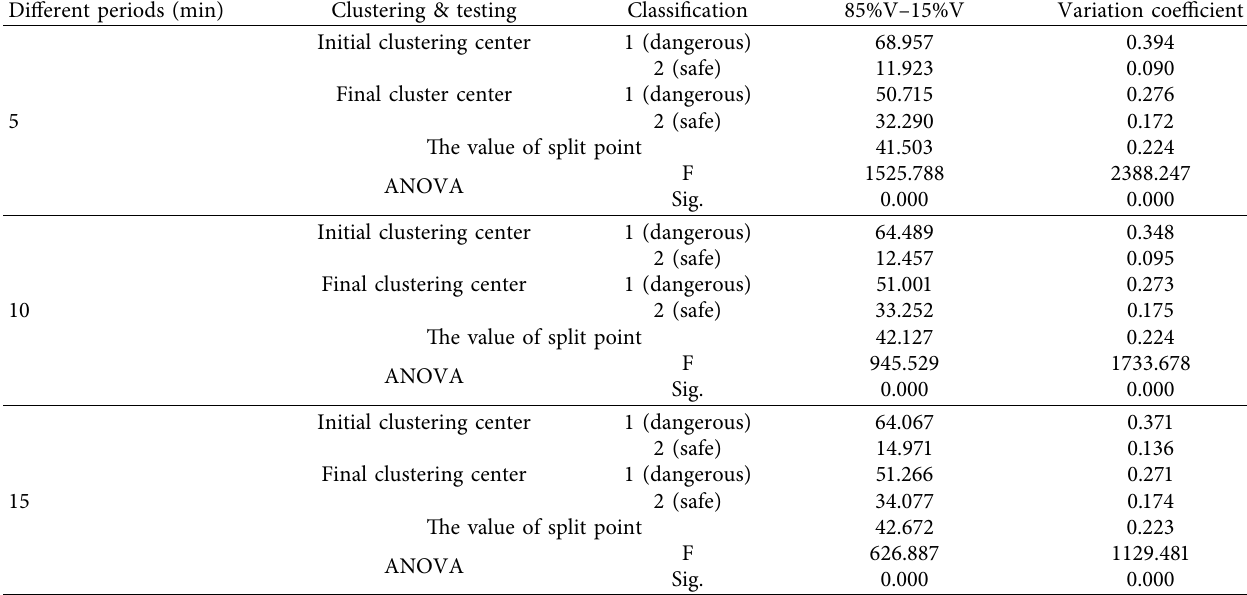
Table 5: k -means clustering analysis in different